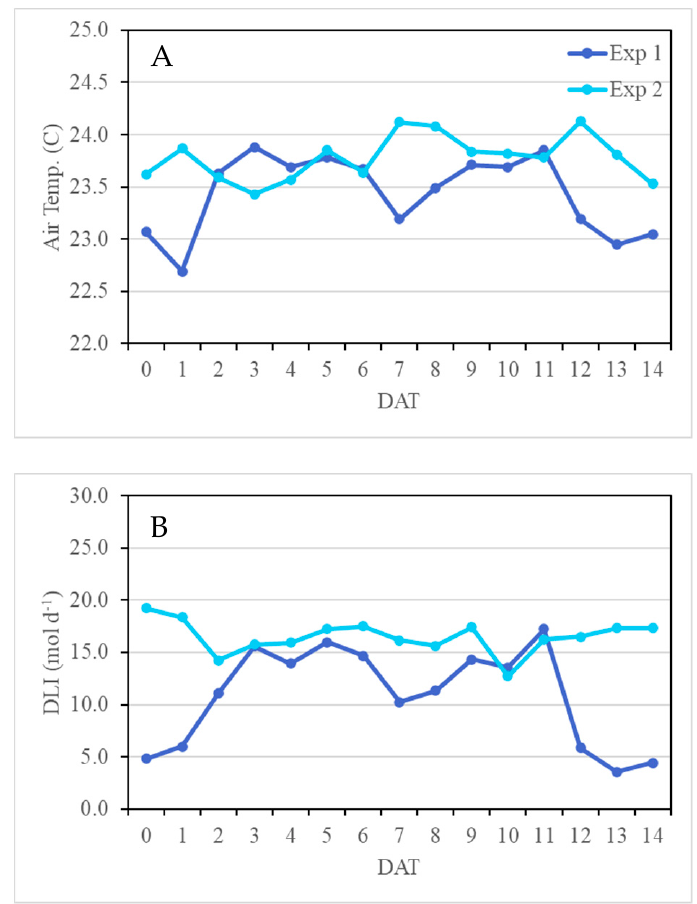
Figure 1. Average daily air temperature ( A ) and daily light integral (DLI) ( B ) in the greenhouse throughout the two experiments. The duration of both experiments was 14 days after transplanting (DAT). Experiments 1 and 2 were conducted from 10–24 September and 1–15 October 2020,